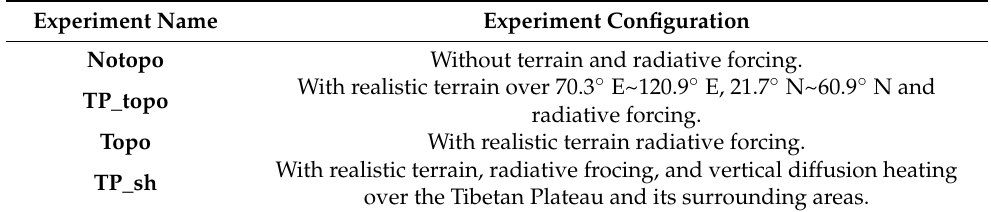
Table 1. Configuration of topographical and thermal forcing in the numerical